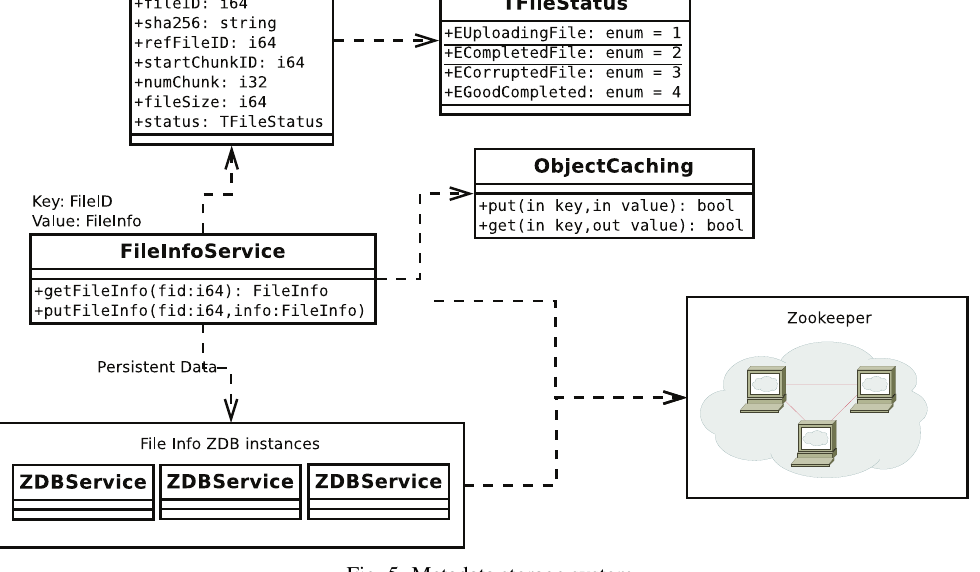
Fig. 5. Metadata storage system